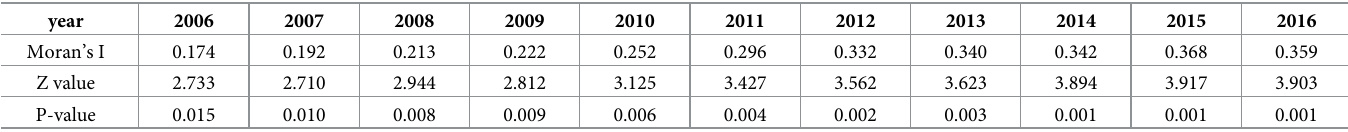
Table 3. Global Moran’s I index of high-quality economic development from 2006 to